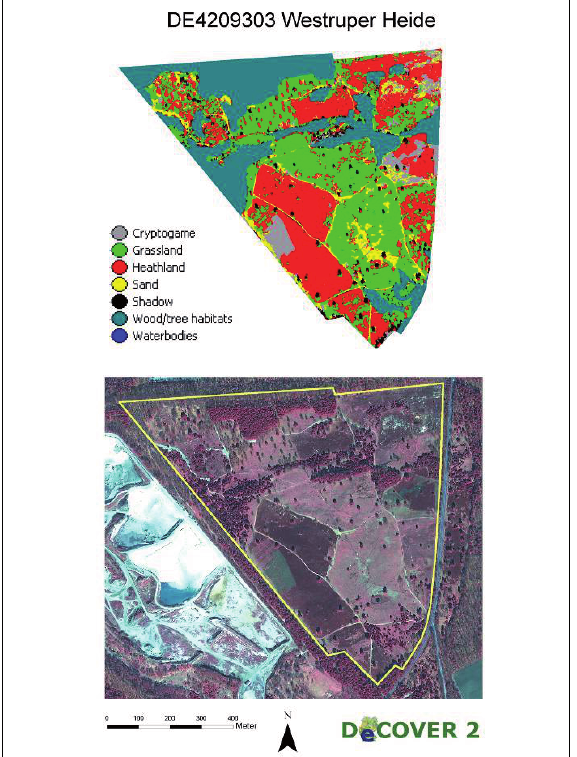
Figure 4. Classification result (top) and Geoeye image (4- 3-2 channel combination) for the test site Westruper